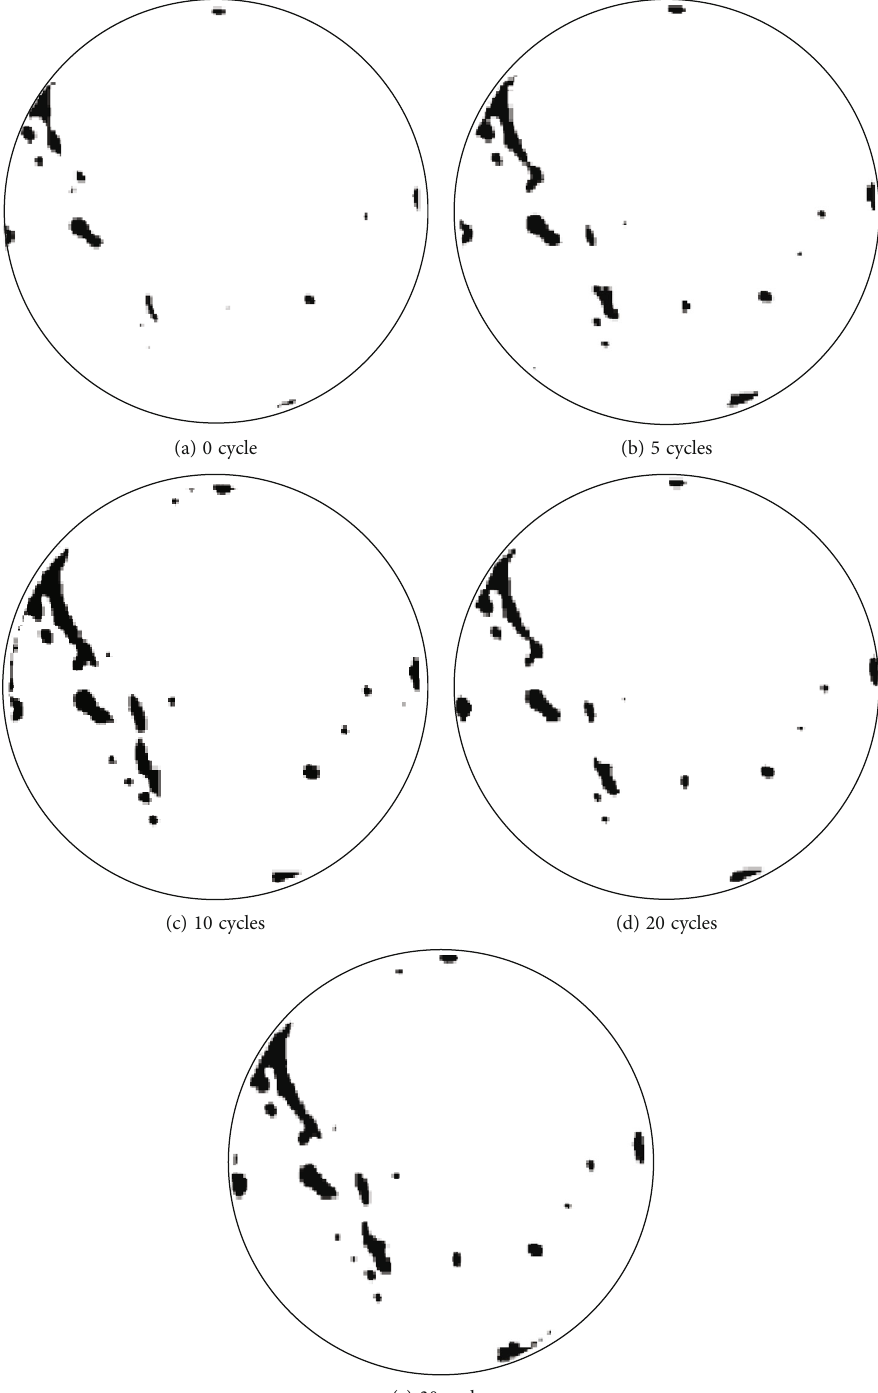
Figure 5: Image segmentation of sandstone CT images under di ff erent freeze-thaw